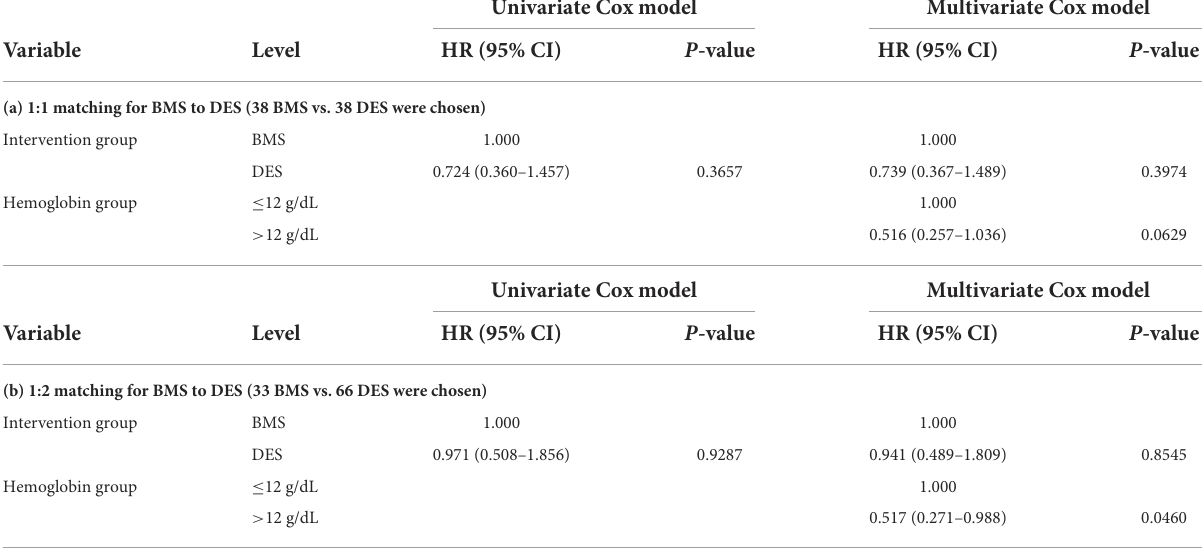
TABLE 5 Analysis of the number of revascularizations between BMS vs. DES group, including 1:1 and 1:2 propensity-matched analysis. Covariate Levels